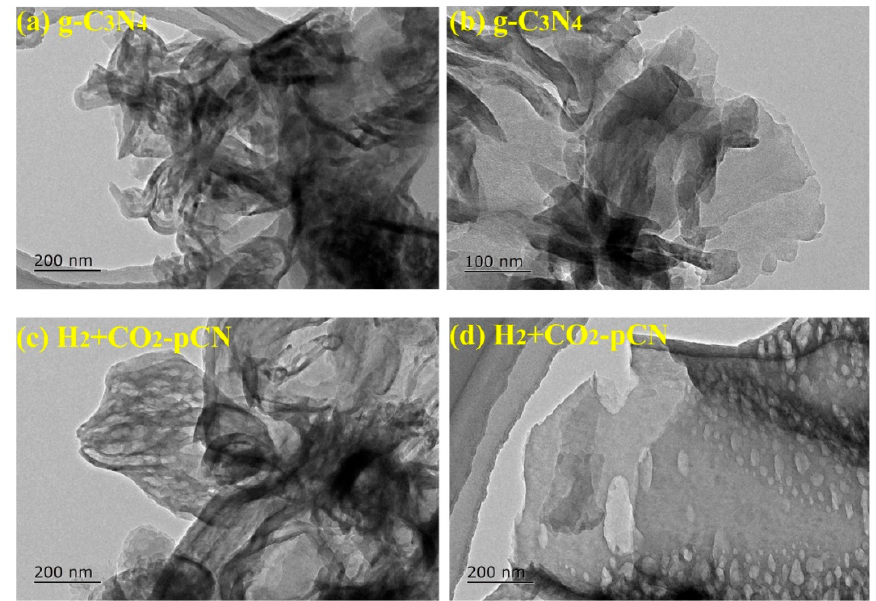
Figure 3. TEM images of raw g-C 3 N 4 and H 2 +CO 2 plasma treated g-C 3 N 4 (H 2 +CO 2 -pCN).